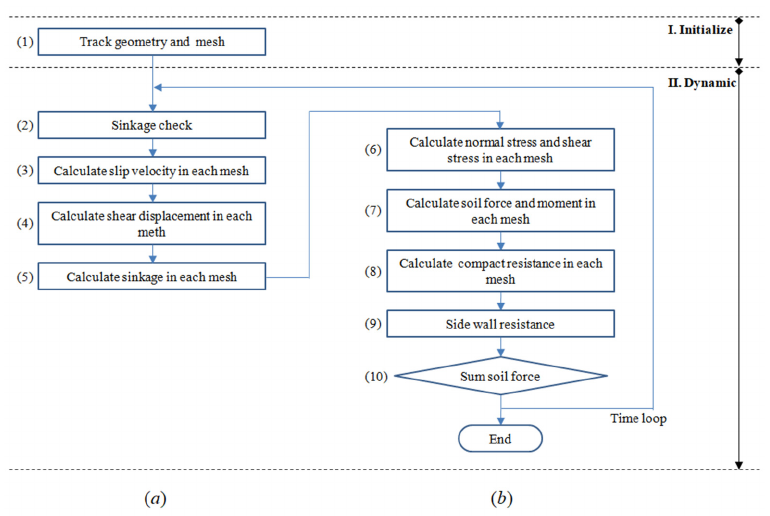
Figure 13. Algorithm for single-body track model: ( a ) the kinematic relationship of the soil contact force acting on the track, ( b ) the soil contact force acting on the track.